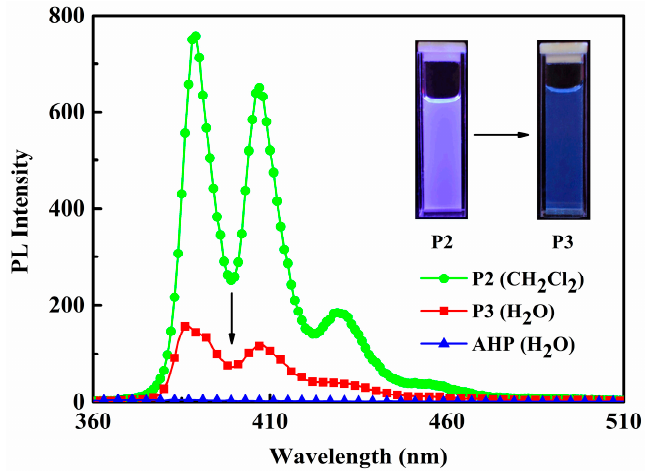
Figure 10. PL spectra of P2 in CH 2 Cl 2 , AHP, and P3 in H 2 O.